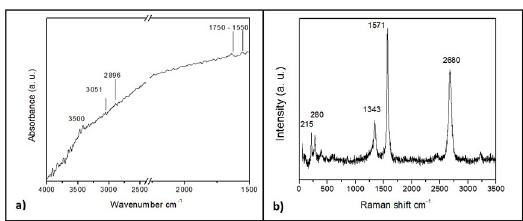
Figure 2. CNTs spectra: a) FTIR, b)